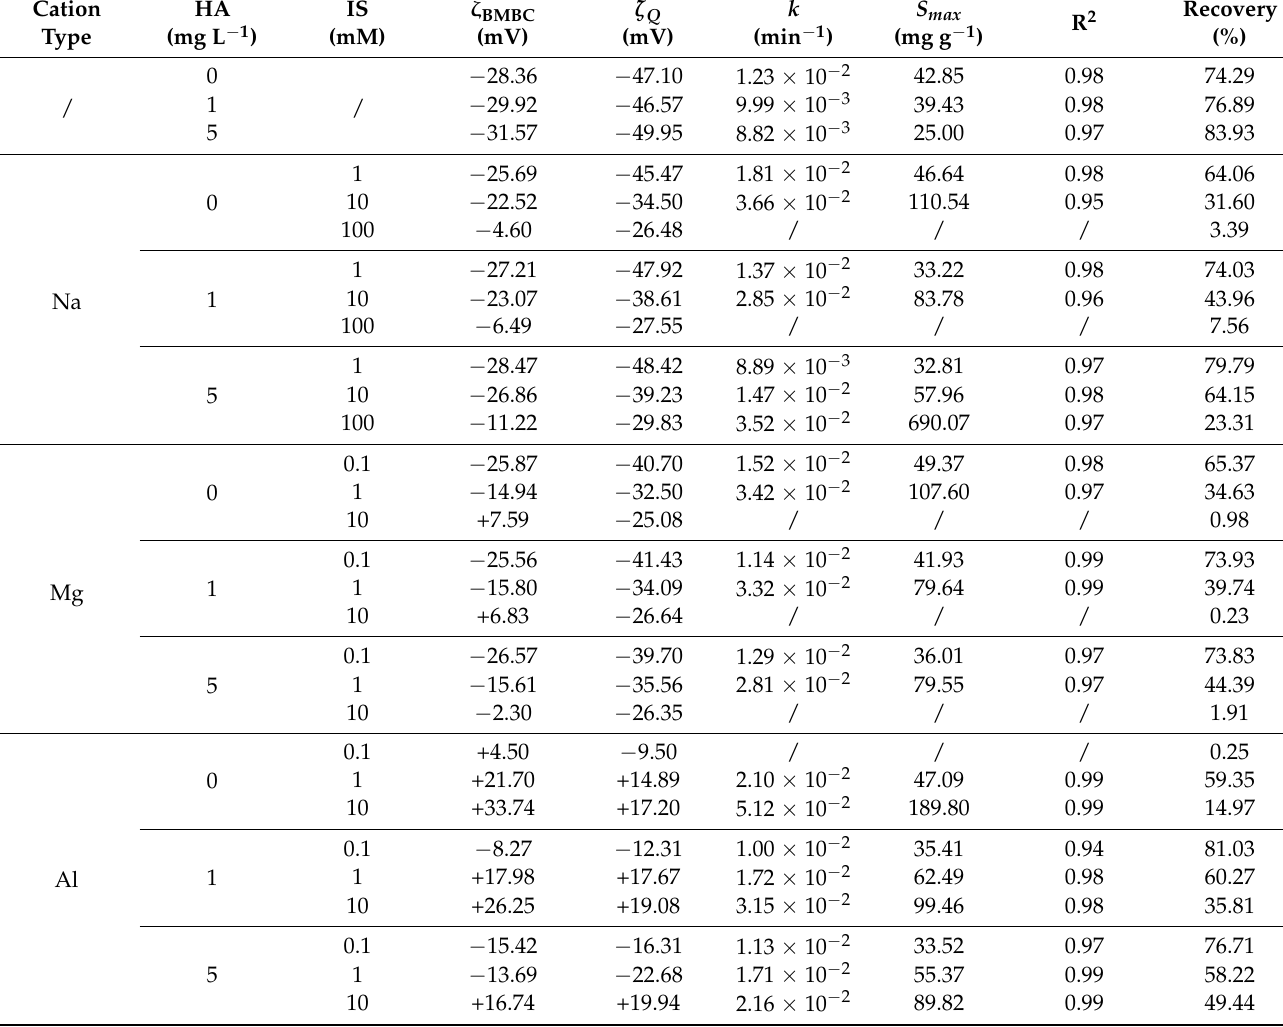
Table 2. Experimental conditions and fitting results for all column